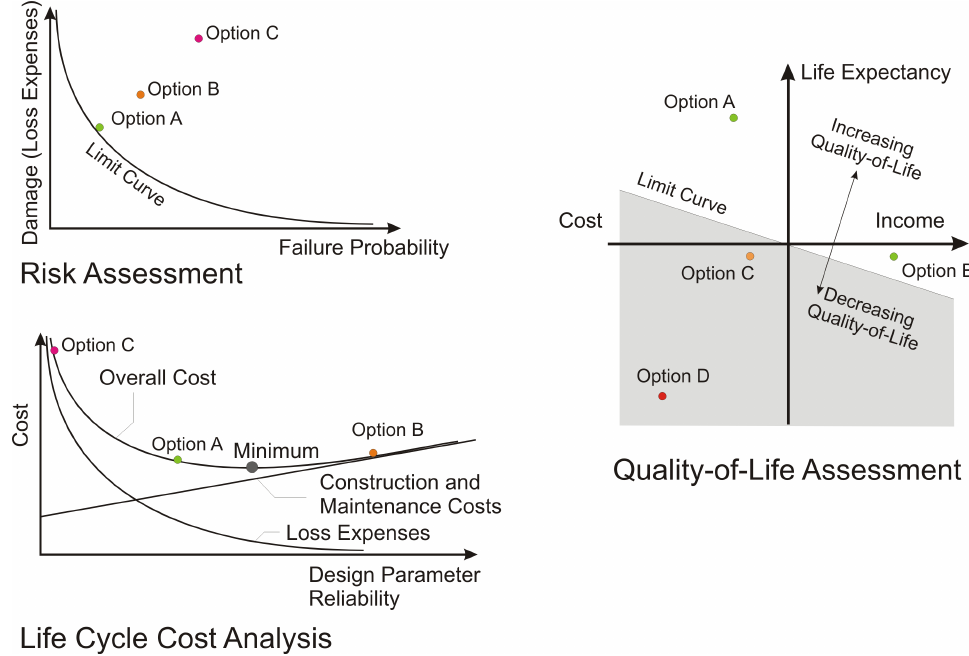
Figure 2. Potential procedures for risk-based asset management of SBB